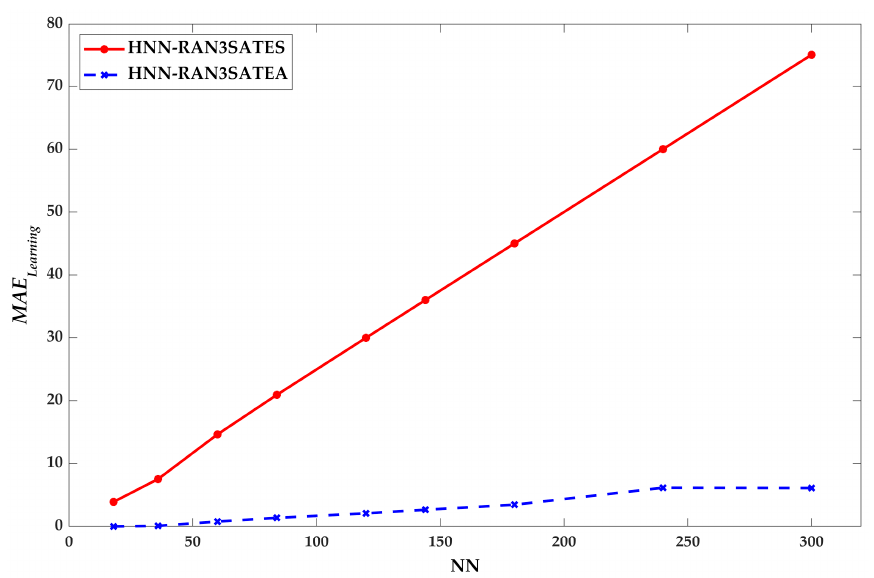
Figure 4. MAE Learning for HNN-RAN3SAT Figure 4. Learning MAE for HNN-RAN3SAT model. Figure 4. Learning MAE for HNN-RAN3SAT model.